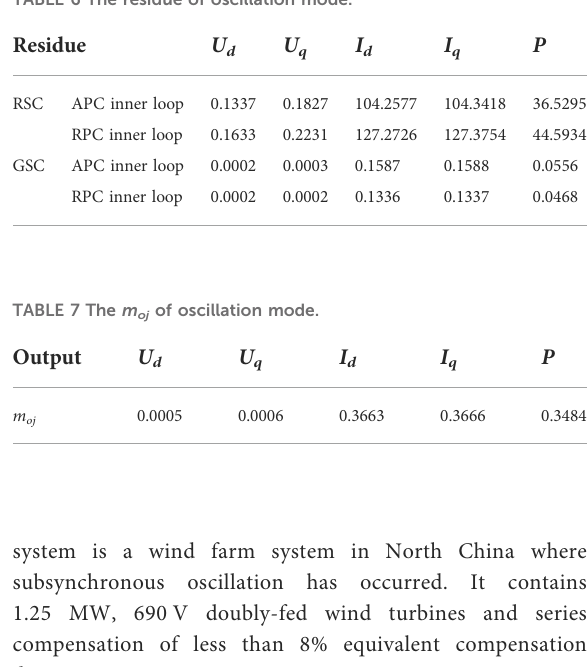
TABLE 6 The residue of oscillation mode.